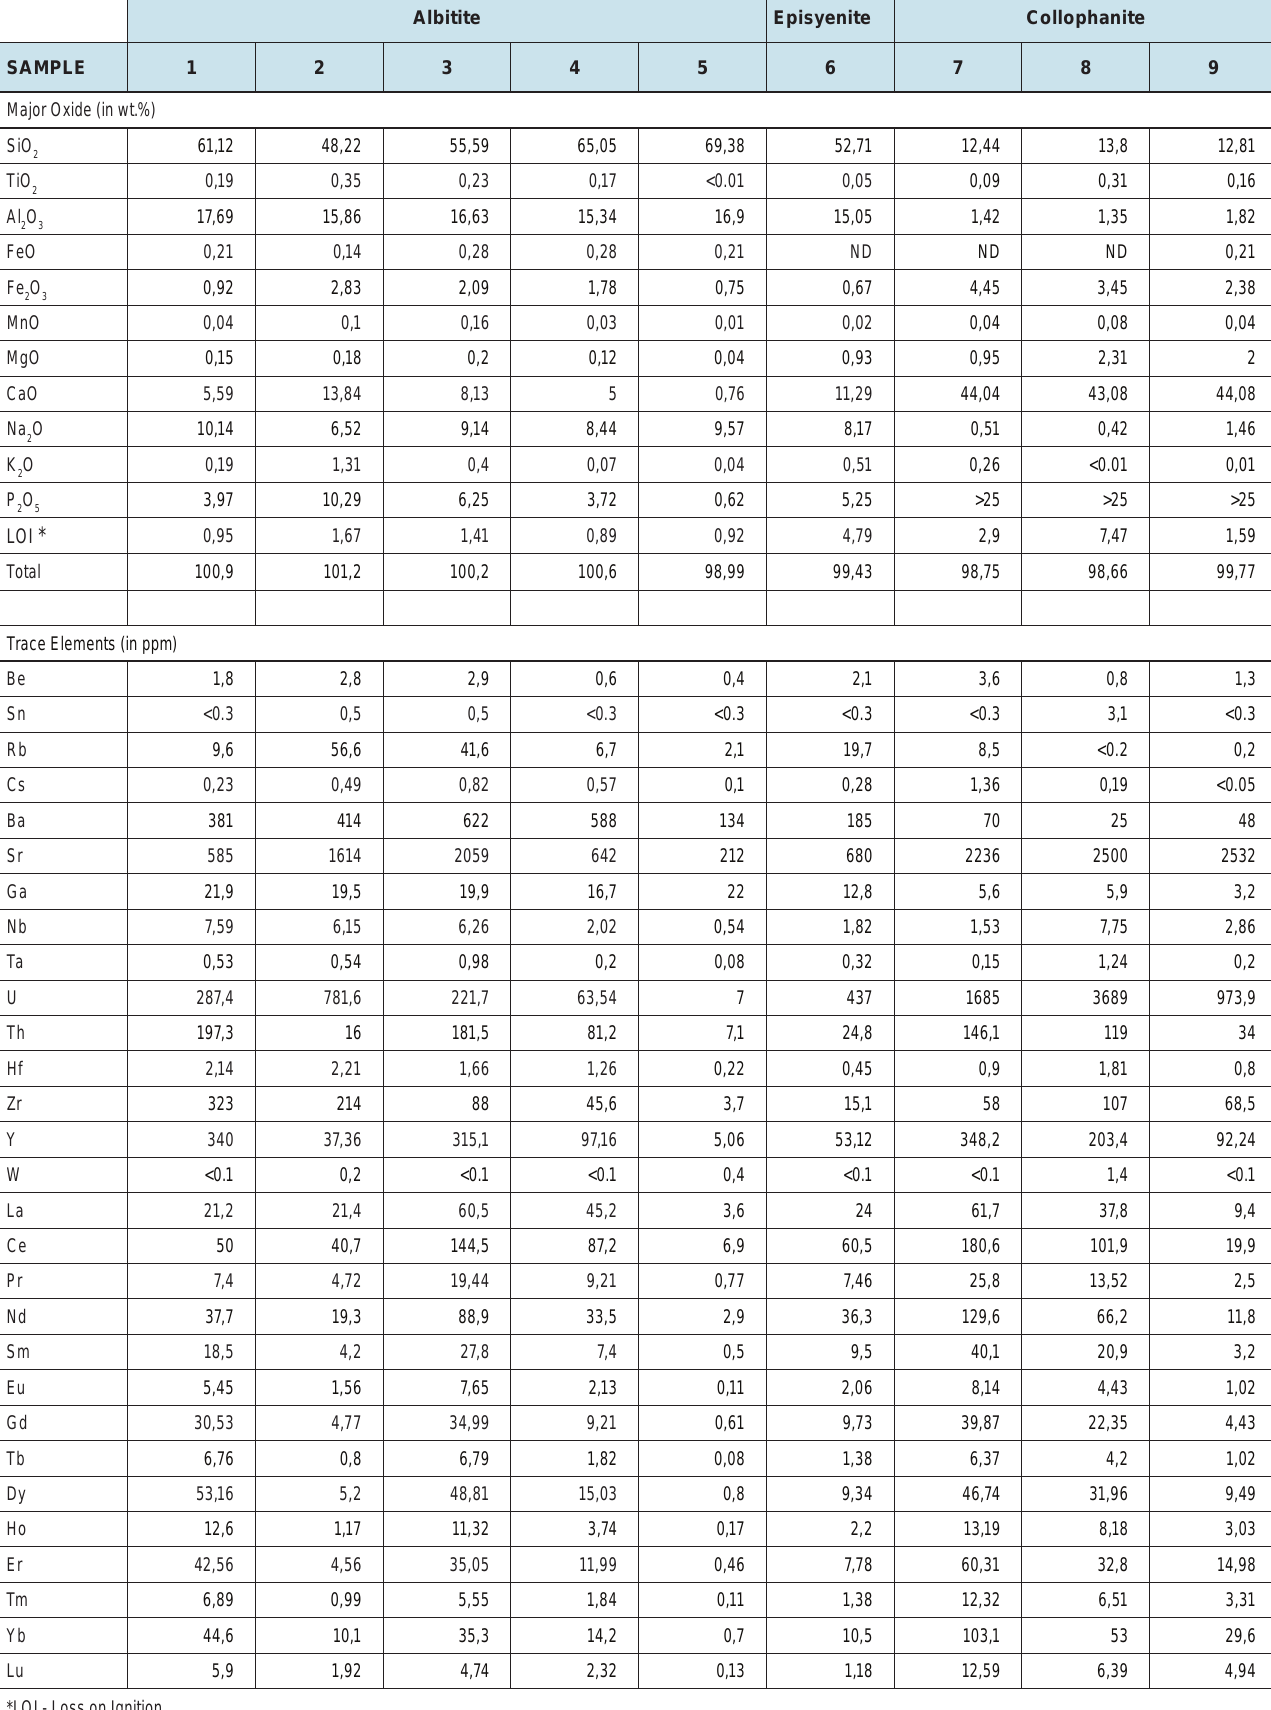
Table 3 - Chemical composition of albitite, episyenite and collophanite (compiled from Cavalcanti and Bessa